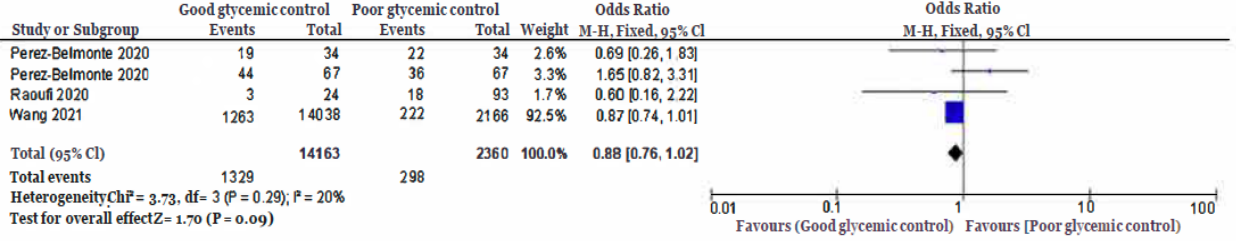
Figure 7. Funnel plot of the outcome of comparison in the well-controlled vs. poorly controlled gly- cemic comparison. [29,30,31] 4. Discussion The results of this meta-analysis indicate that diabetes is a key factor among the most common comorbidities, as it is significantly associated with the severity and mortality of coronavirus infection. The main goal of this study was to determine whether there is a link between glycemic control and death rate or complications in critically ill COVID-19 patients. Healthcare workers use several blood-glucose-lowering medications to treat COVID-19. According to the results obtained from our meta-analysis, glycemic manage- ment is heavily linked to mortality and the incidence of severe complications, including ICU admission and COVID-19 in patients with diabetes. This review provides evidence of the impact of glycemic management in this group of patients. However, due to the limitations of studies concerning glycemic control interventions among COVID-19 pa- tients in our meta-analysis, the relationship between various treatments and outcomes in critically ill patients with hyperglycemia and COVID-19 infection needs to be analyzed in more extensive clinical studies. 4.1. Glucose Control in Hospital Insulin therapy remains the most commonly used glucose-lowering medication in critically ill patients. The main aims of treatment are to minimize BG variability, reduce the risk of hypoglycemia, and develop optimal glycemic management. However, there is no ideal treatment protocol for hyperglycemia management in critically ill patients or clear evidence to demonstrate the benefit of one approach over the other(s). A study by Yang et al. indicated that insulin treatment may increase fatality and several complications